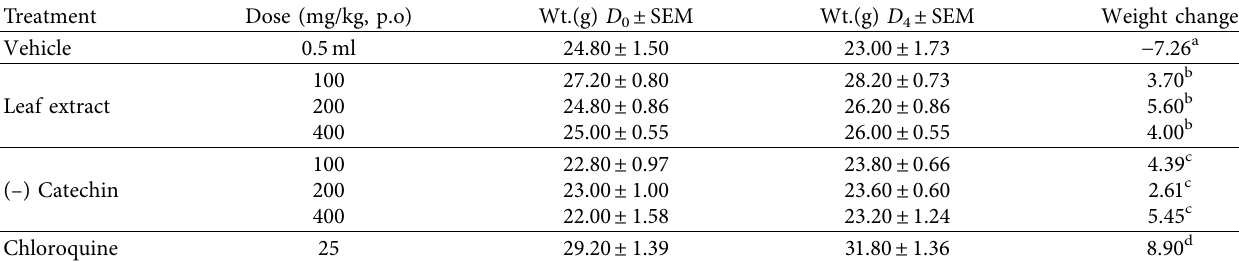
Table 2: Body weight of Plasmodium berghei -infected mice after administration of the 80% methanol leaf extract of Osyris quadripartita and ( − ) catechin.